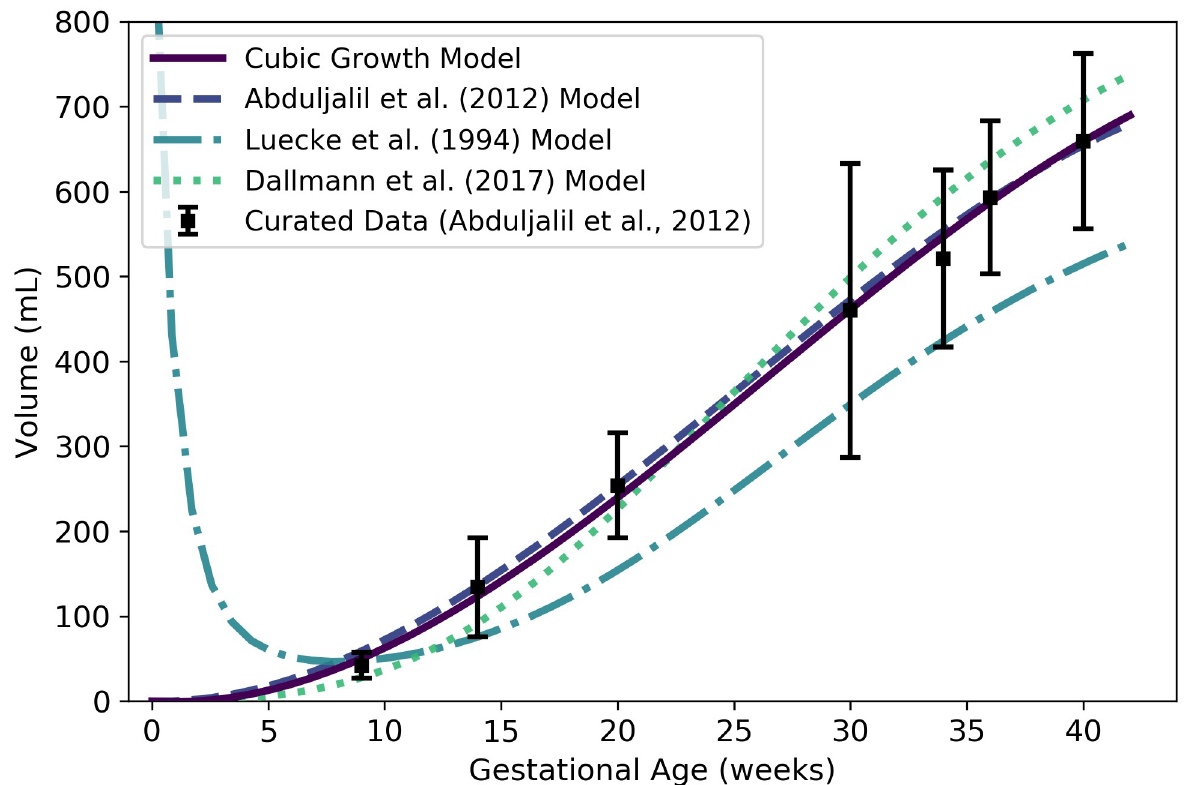
Fig 6. Placenta volume vs. gestational age. The cubic growth model (solid line) given by Eq 8 was selected as the most parsimonious model in our analysis. The model of Abduljalil et al. [28], also a cubic polynomial model, was calibrated using the same curated data set [28] used by us. The model of Luecke et al. [15] was calibrated using different data and assumes a relationship between placenta volume and fetal mass. Dallmann et al. [3] calibrated their cubic model with different data. 2 weeks, so neither the placenta nor the embryo, itself, come into existence until after that time. At a fetal age of about 4 days, or a gestational age of about 18 days, the cells in the periph- ery of the blastocyst (i.e., the early embryo) become distinguishable as a trophoblast; this tro-